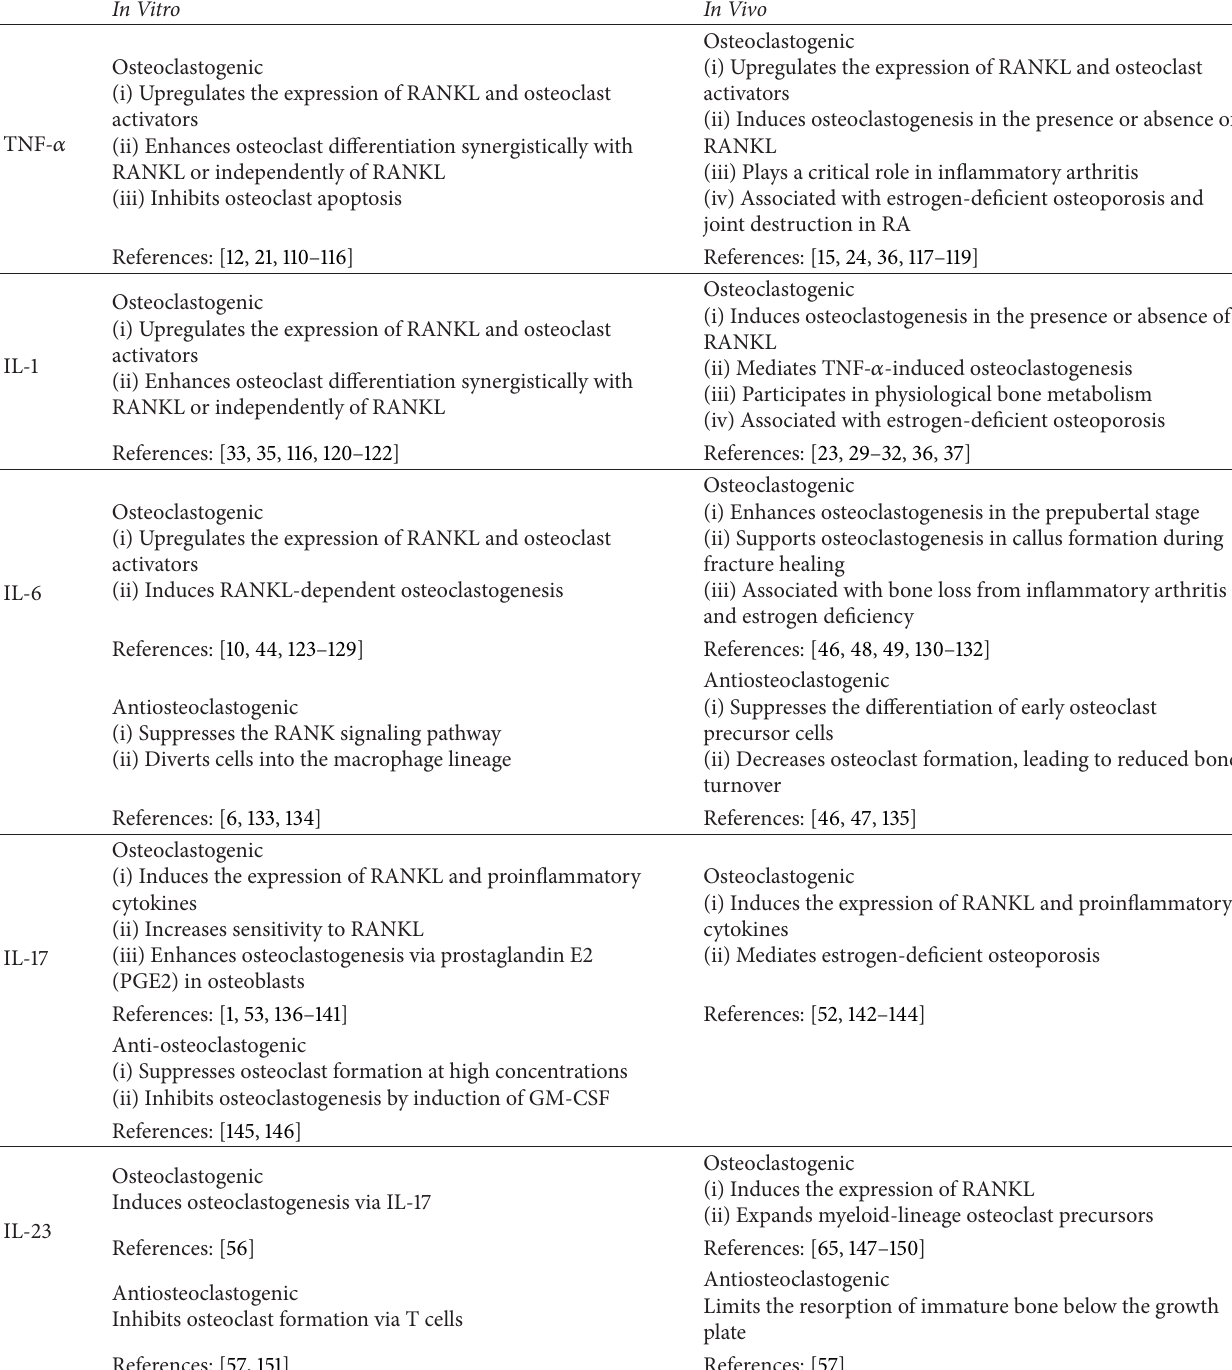
Table 1: Roles of cytokines on